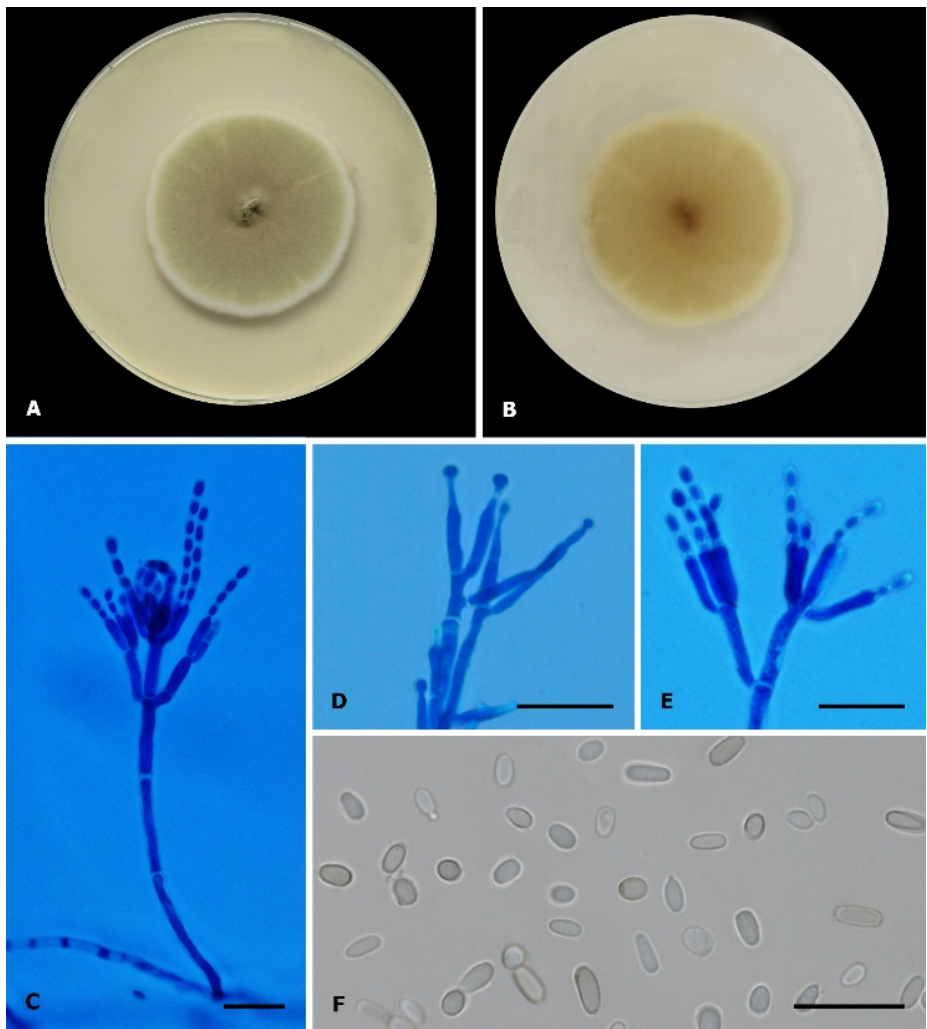
Figure 2. Penicillium digitatum (CEMT-2). ( A , B ) Colony on PDA, in front and reverse respectively, incubated at 25 °C for 7 days. ( C – E ) Conidiophores, metulae, phialides, and conidia (Cotton blue Lactophenol mounting solution). ( F ) Conidia (Lactophenol mounting solution). Scale bars: 20 µm.